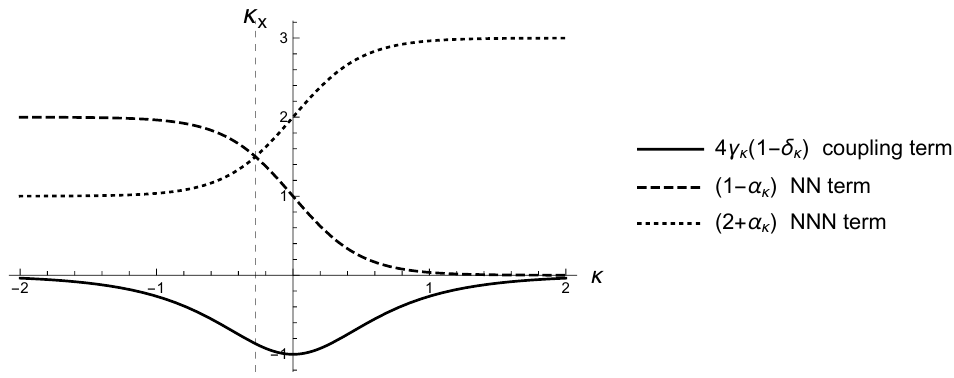
Figure 4: Nearest and next-nearest neighbor branch state energies for the two- magnon excitations at K = π/ 2 given by Eqs. (27,28). The crossing value where the Eqs. (27,28) have the same energy at κ is highlighted by the grey vertical dashed x line. The solid black line shows the coupling term in Eqs. (20,